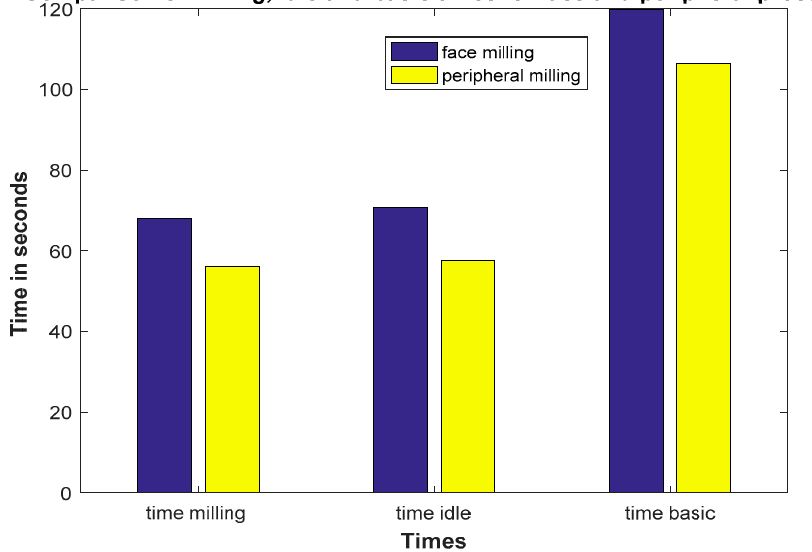
Figure 6. Comparison of milling, idle and basic times for face and peripheral process.